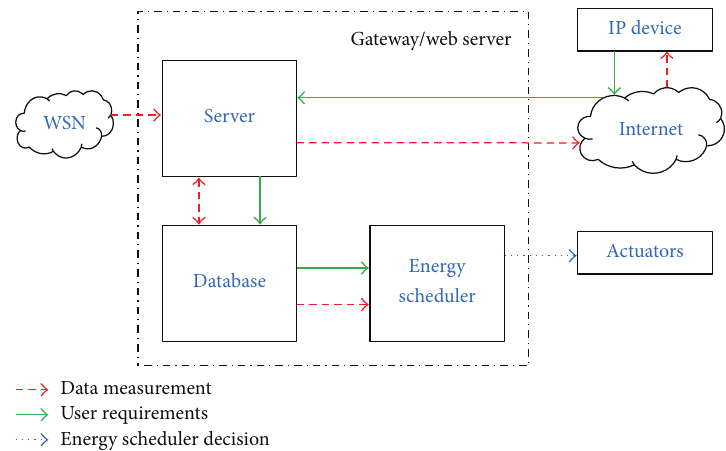
Figure 2: System model of the